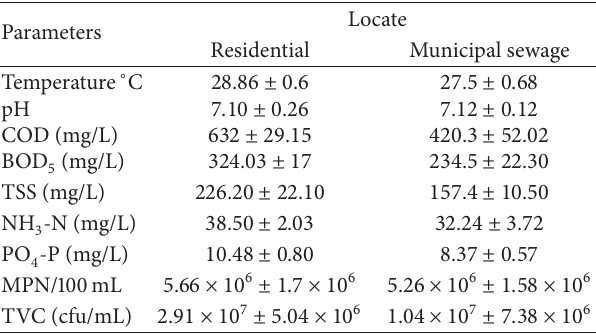
Table 2: The comparison of the characteristics of residential wastewater and municipal sewage wastewater.